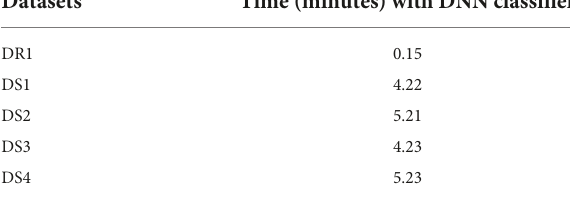
TABLE 10 Execution time of different